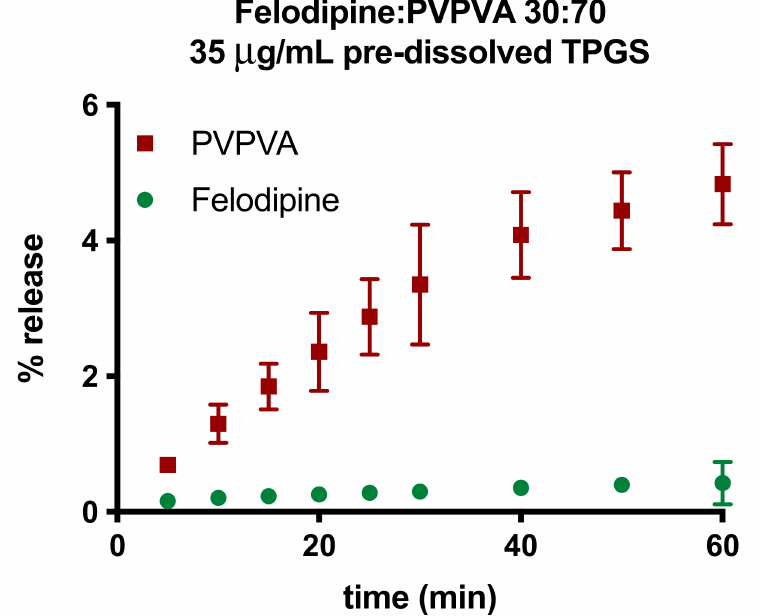
Figure 7. Percent release versus time profiles for amorphous felodipine and PVPVA for 30% DL binary ASD (without TPGS) with pre-dissolved TPGS in the dissolution medium. The ratio in the legend represents weight ratios of ASD components and the amount of pre-dissolved TPGS (35 µ g/mL). Error bars represent standard deviations, n = 3, and they may be smaller than symbols in some instances.